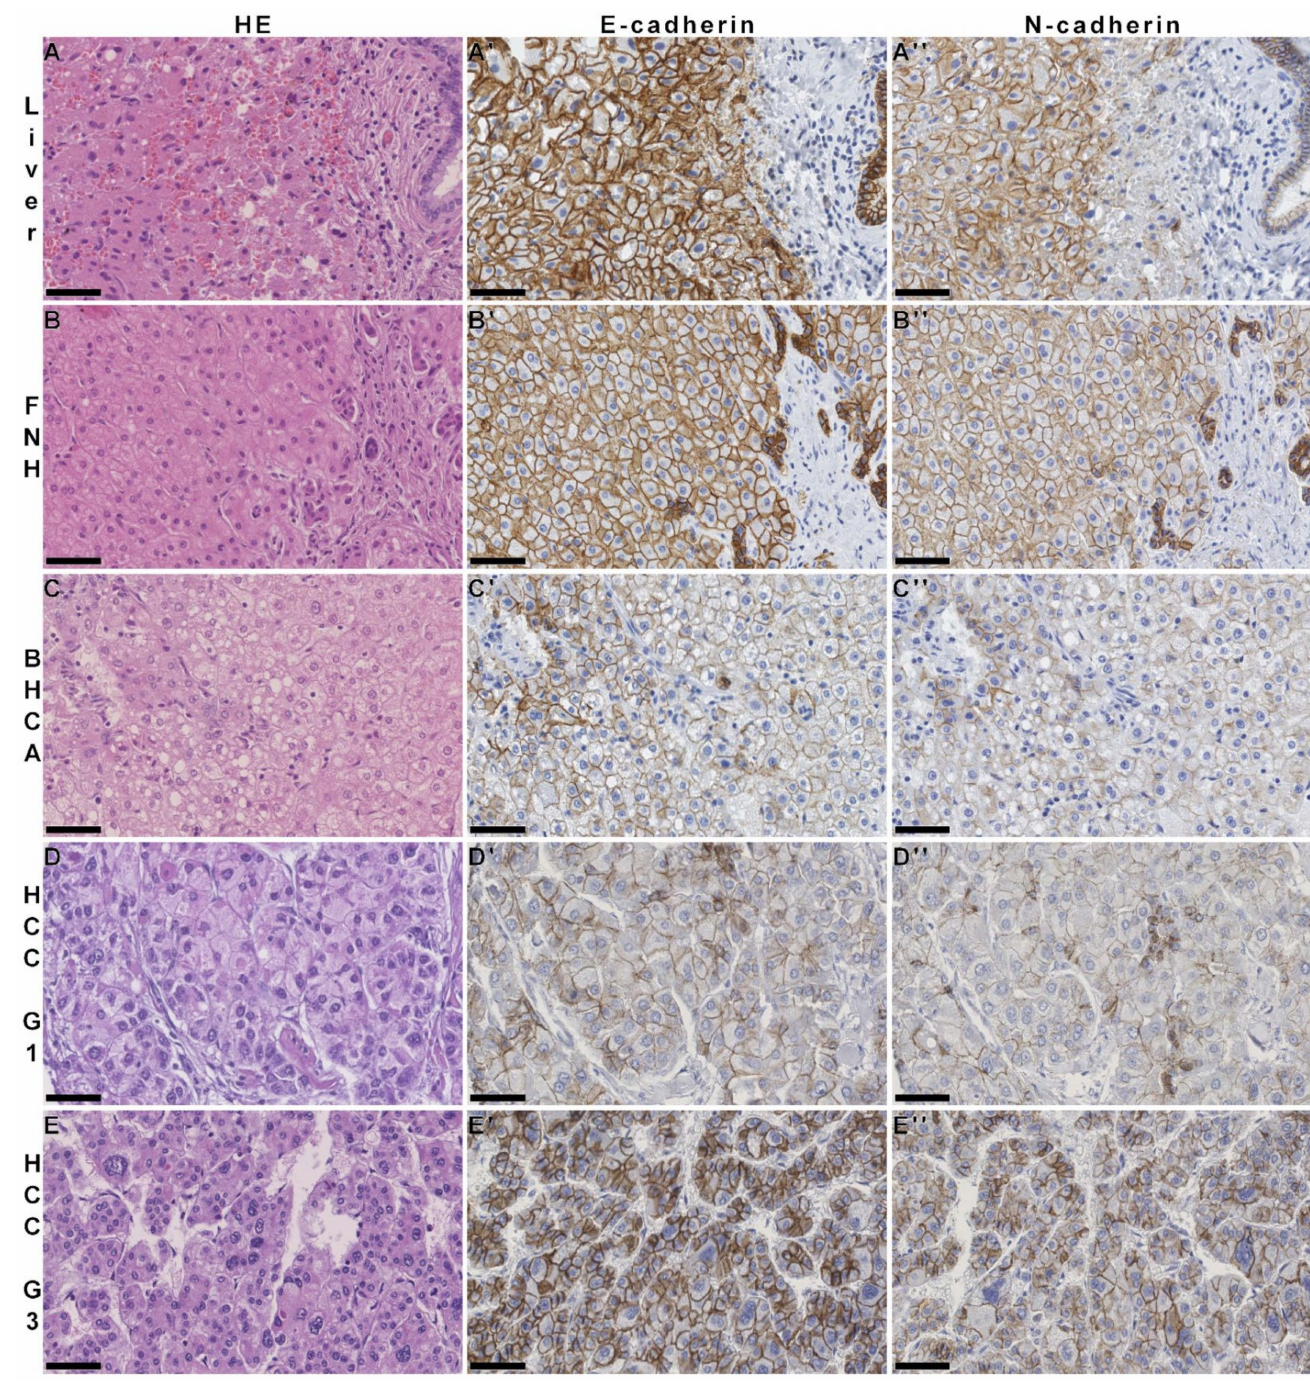
Figure 5. Immunohistochemistry of E- and N-cadherin in non-neoplastic liver and derived tumors. In each row, hematoxylin and eosin staining as well as E-cadherin ( A (cid:48) – E (cid:48) ) and N-cadherin ( A (cid:48)(cid:48) – E (cid:48)(cid:48) ) immunohistochemistry of normal liver tissue ( A ), FNH ( B ), β -catenin-activated HCA (BHCA; ( C )), well-differentiated HCC (HCC G1; ( D )) and poorly differentiated HCC (HCC G3, ( E )). E- and N-cadherin are both coexpressed in hepatocytes, HCA, and HCC. Note slightly zonal expression pattern in normal liver with lower N-cadherin expression and higher E-cadherin expression in normal bile ducts ( A – A (cid:48)(cid:48) ). Bars: 50 µ m